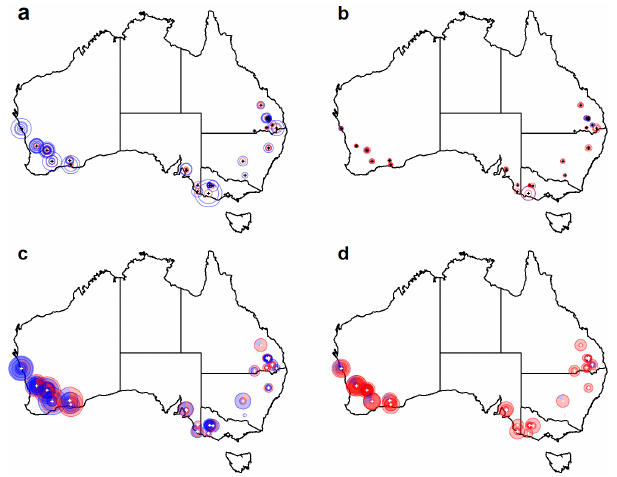
Figure 3. Projected SOC ( a and b ) and its percentage uncertainty ( c and d ) under high ( a and c ) and low ( b and d ) carbon input sce- narios after 100-year simulations in 90 experiments across 26 sites. Concentric circles show the different experiments at the same site. The sizes of the circles correspond to the projected average of SOC content ( a and b ) and the corresponding percentage uncertainty ( c and d ). Blue and red circles indicate that the average of the 700 sim- ulations is increased and decreased, respectively, compared with the SOC content at the start of the projection. Blue and red sectors of the circles in (c) and (d) indicate the fraction of 700 bootstrapping simulations that shows an increase and a decrease in the projected SOC, respectively, compared with the SOC content at the start of the projection